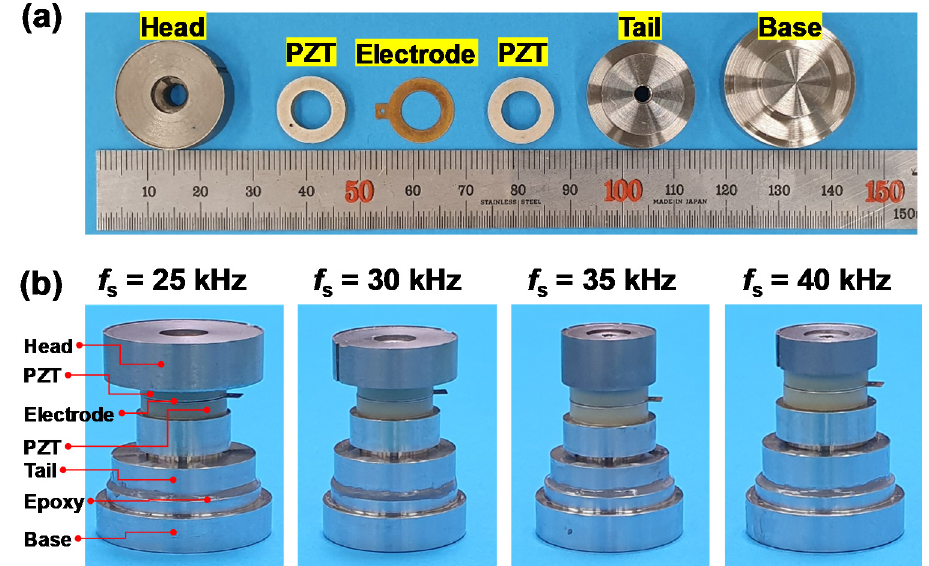
Figure 6. ( a ) Constituent components and PZT ceramic rings manufactured according to optimized design ( f s = 25 kHz); ( b ) Images of four accelerometer modules fabricated according to optimized designs ( f s = 25, 30, 35, 40 kHz). Table 3. Room ‐ temperature physical properties of PZT ceramic rings.